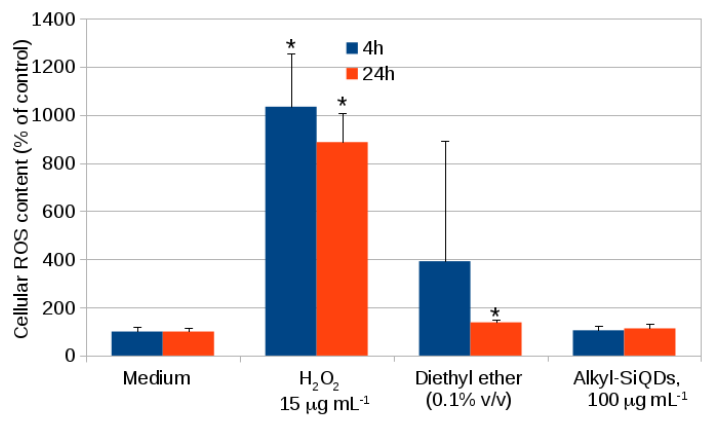
Figure 7. Cellular ROS content measured in CACO-2 cells after exposure to SiQDs for 4 h and 24 h using H2DCFDA (2 (cid:48) ,7 (cid:48) -dichlorodihydrofluorescein diacetate, Sigma-Aldrich, Gillingham, UK). The ROS contents (% of control) are indicated as means ± SD for n = 3 experiments. Significant effects ( p < 0.05) are marked with an asterisk *.